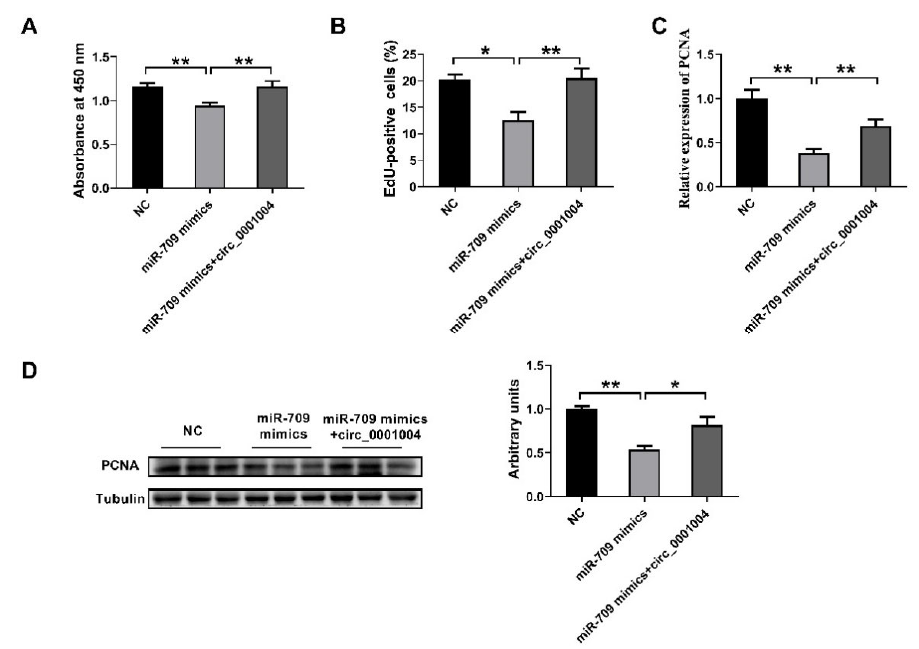
Figure 5. Effects of rno_circ_0001004 in reversing the inhibition of cell proliferation by miR-709. ( A ) The GH 3 proliferation was evaluated with CCK-8 kits. ( B ) EdU-positive cells. ( C ) PCNA mRNA expression quantified by qRT-PCR. ( D ) Western blot assay for PCNA protein expression. (* p < 0.05; ** p <